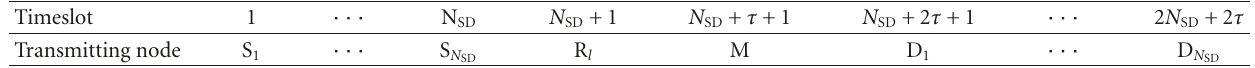
Table 3: Timeslots at which the nodes transmit their training sequences for channel estimation protocol B1. Timeslot 1 ··· N SD N SD + 1 N SD + τ + 1 N SD + 2 τ + 1 ··· 2 N SD + 2 τ Transmitting node S 1 ··· S N R l M D 1 ··· D N SD